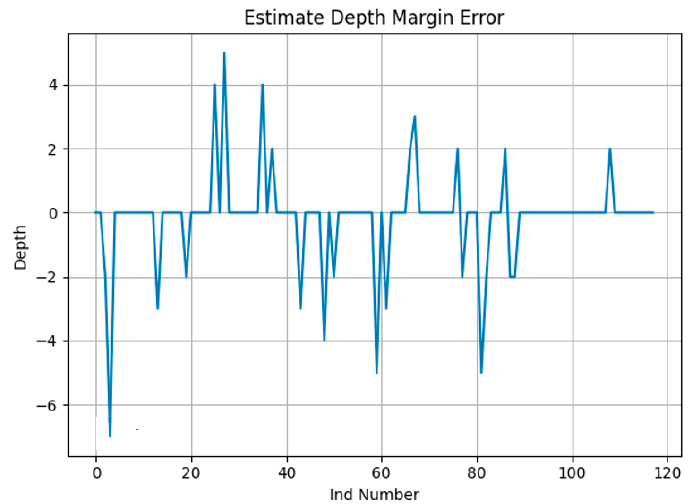
Figure 8. Depth difference between the auto-sizing algorithm using linear regression and the average of streams A and B for an outage data.